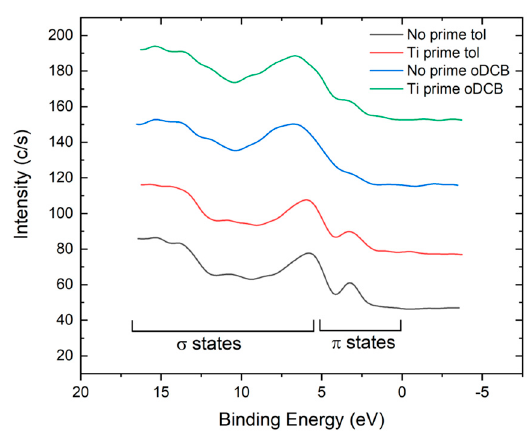
Figure 4. Density of states in the valence band region measured for the four different